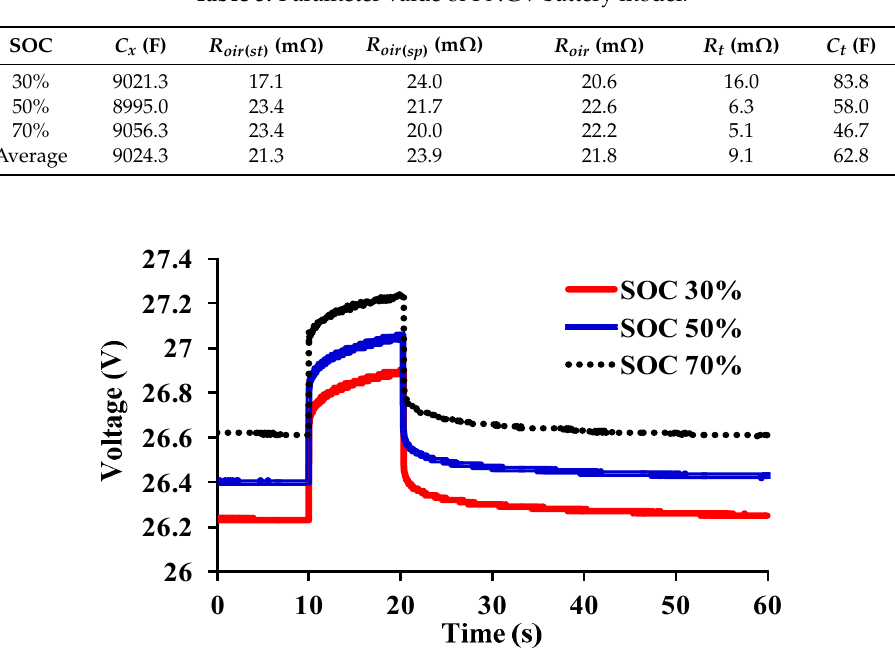
Figure 3. Voltage − time characteristics for a LiFePO 4 battery pack (LBP) at states of charge (SOCs) 30%, 50%, and 70%.